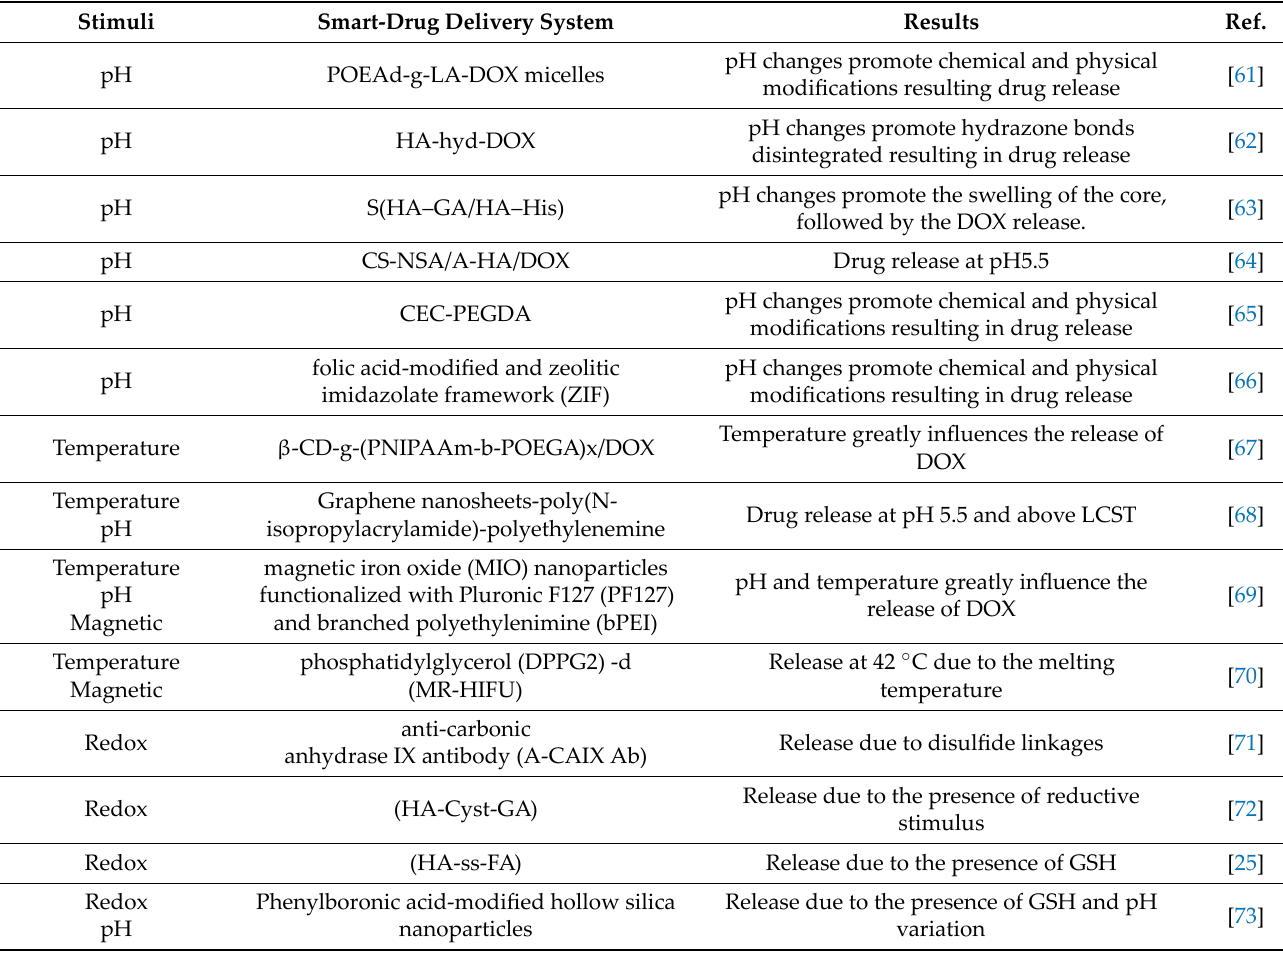
Table 1. Summary of featured stimuli‑responsive